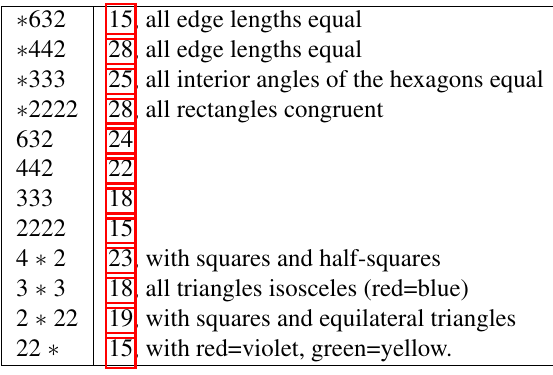
Tab. 2: Symmetry groups with corresponding figure labels and further specifications.